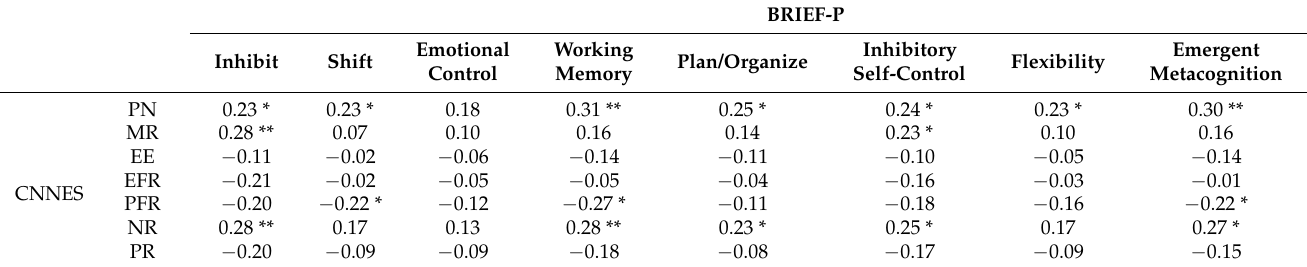
Table 4. Associations between mothers’ reports on CCNES and teachers’ reports on BRIEF-P scales, controlling for child’s sex and